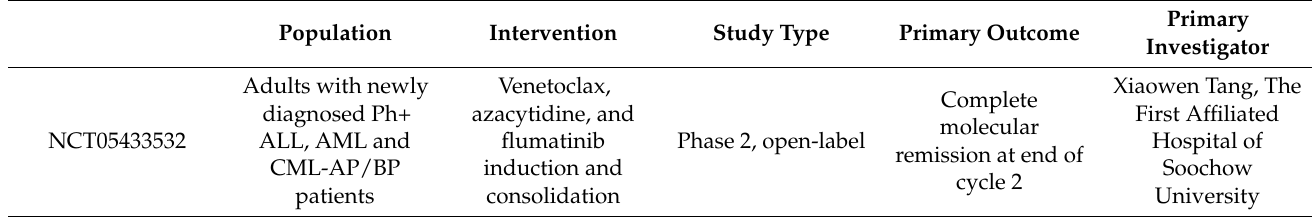
Table 2. Ongoing registered clinical trials with venetoclax-based treatments in